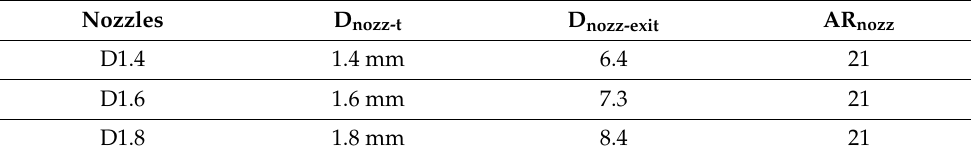
Figure 2. The dimension of the ejector and primary nozzle. Table 1. The primary nozzle dimension.